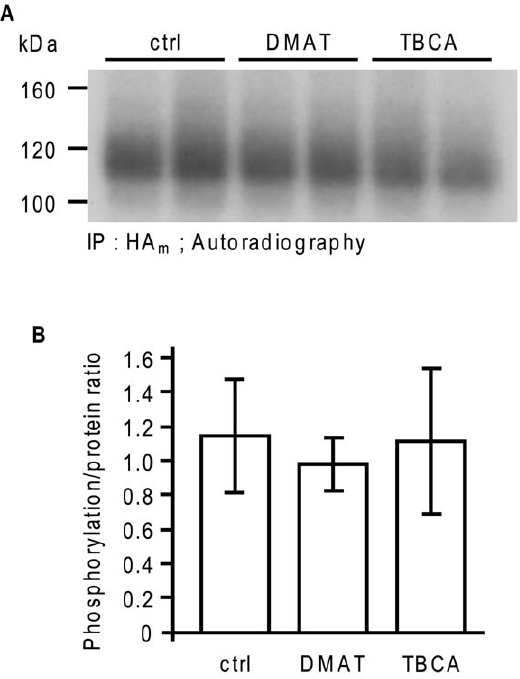
Figure 5. CK2 does not phosphorylate TRPC6. A , T6.11 cells were labeled in the presence or not of 10 m M DMAT or 10 m M TBCA for 4 h before the cells were lysed and TRPC6 was immunoprecipitated and separated by SDS-PAGE. The autoradiogram is representative of six independent experiments. B , The densitometric analyses of autoradio- grams and Western blots (not shown) from A and the calculated ratios are relative to the control (100%). The histogram represents the average 6 SD of six independent experiments.